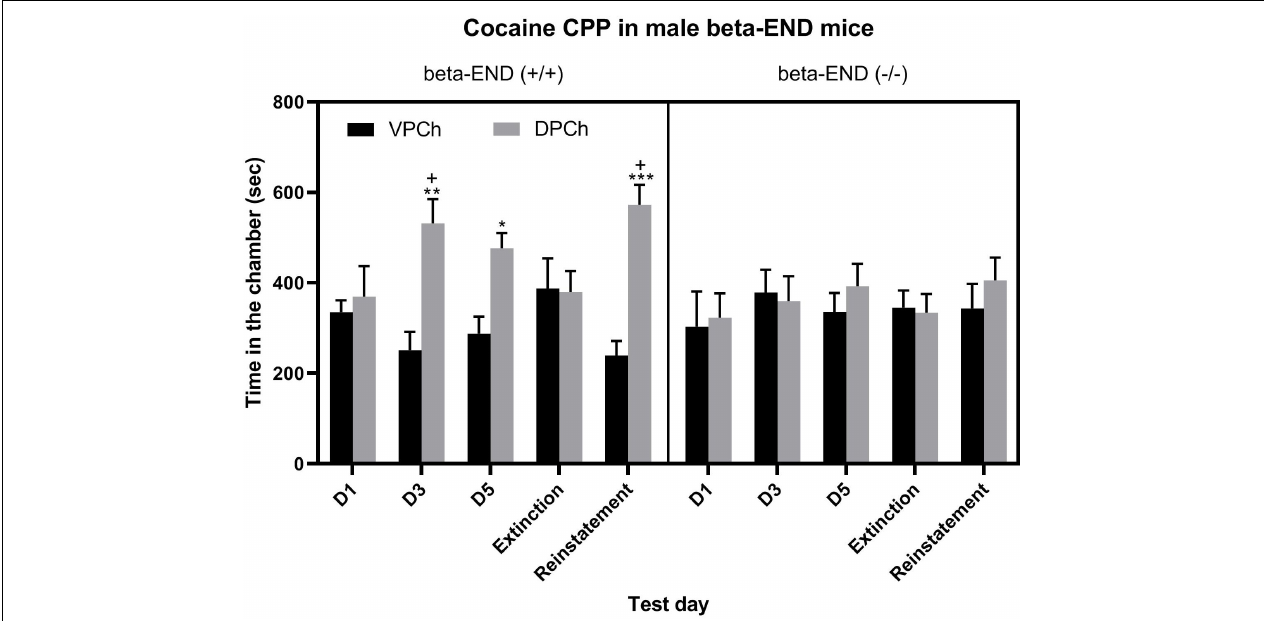
FIGURE 1 | CPP was blunted in male mice lacking beta-endorphin compared to their wild-type controls following single and repeated conditioning with cocaine (15 mg/kg) as well as on the reinstatement test day following a challenge dose of cocaine (7.5 mg/kg, i.p.). Data are mean ( ± SEM) of the amount of time that animals ( n = 6–8 mice per genotype) spent in the drug-paired chamber (DPCh) versus vehicle-paired chamber (VPCh) before (day 1; D1) and after single (day 3; D3) and repeated (day 5; D5) conditioning with cocaine as well as on the extinction and reinstatement test days. * P < 0.05; ** P < 0.01; *** P < 0.001 vs. its respective VPCh; + P < 0.05 vs. mice lacking beta-END on that test